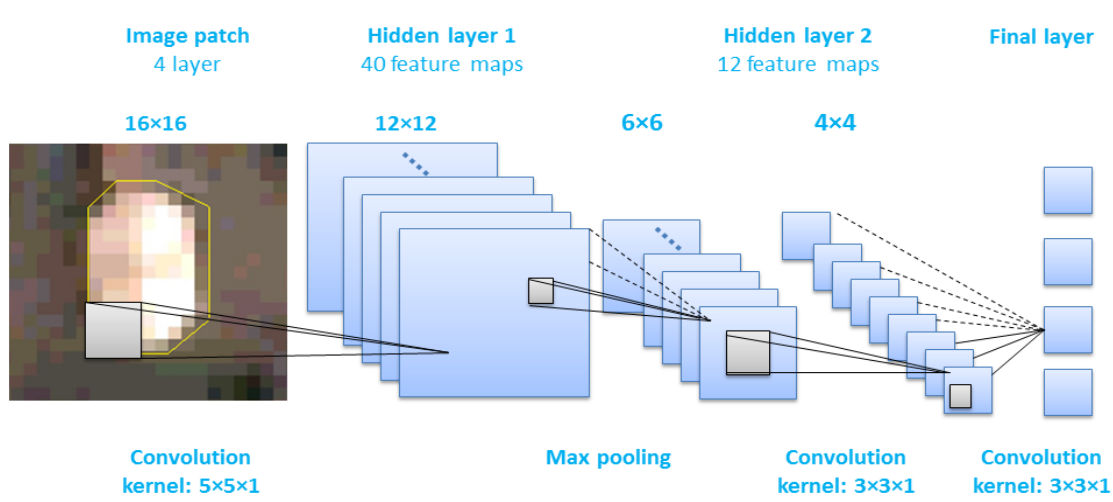
Figure 3. The structure of our CNN for mapping of dwellings in a refugee camp